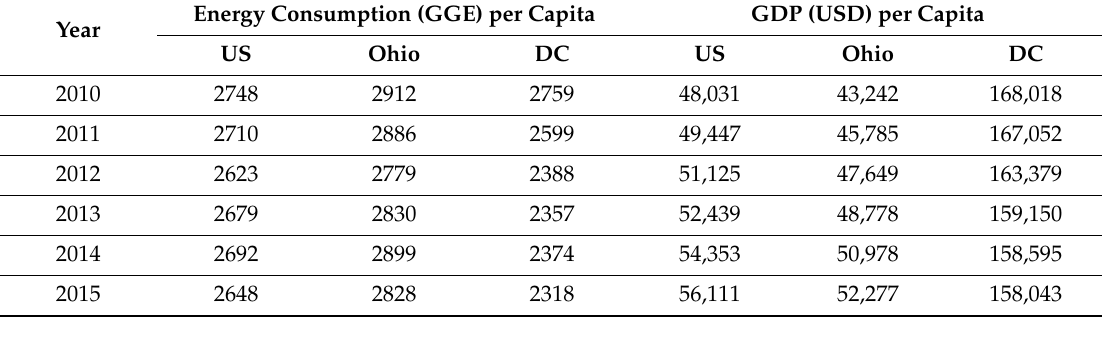
Table 9. Ohio and D.C. comparison, per capita basis.